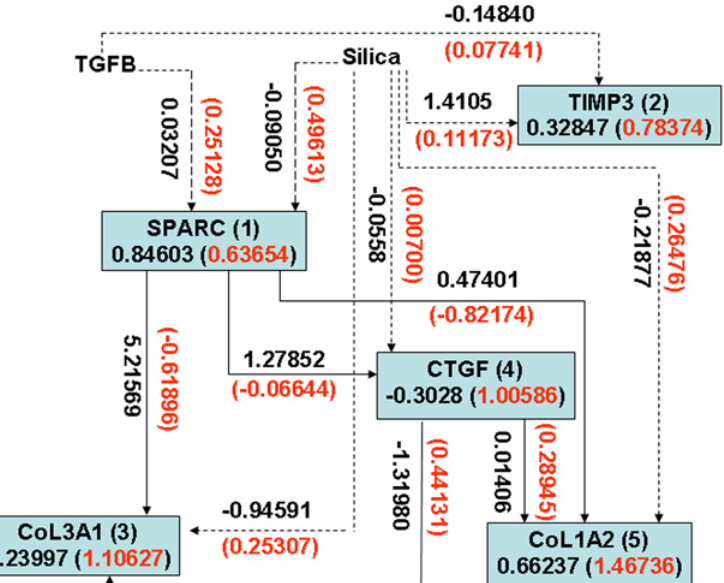
Figure 1. State-space model for the regulatory gene network responding to silica stimulation in cultured human fibroblasts. The numbers next to the edges are the coefficients in the state-space equations for the normal (black color) and SSc (red color) fibroblasts, respectively. The numbers in the boxes denote the mean expression values of the genes in normal (black color) and SSc (red color) fibroblasts.